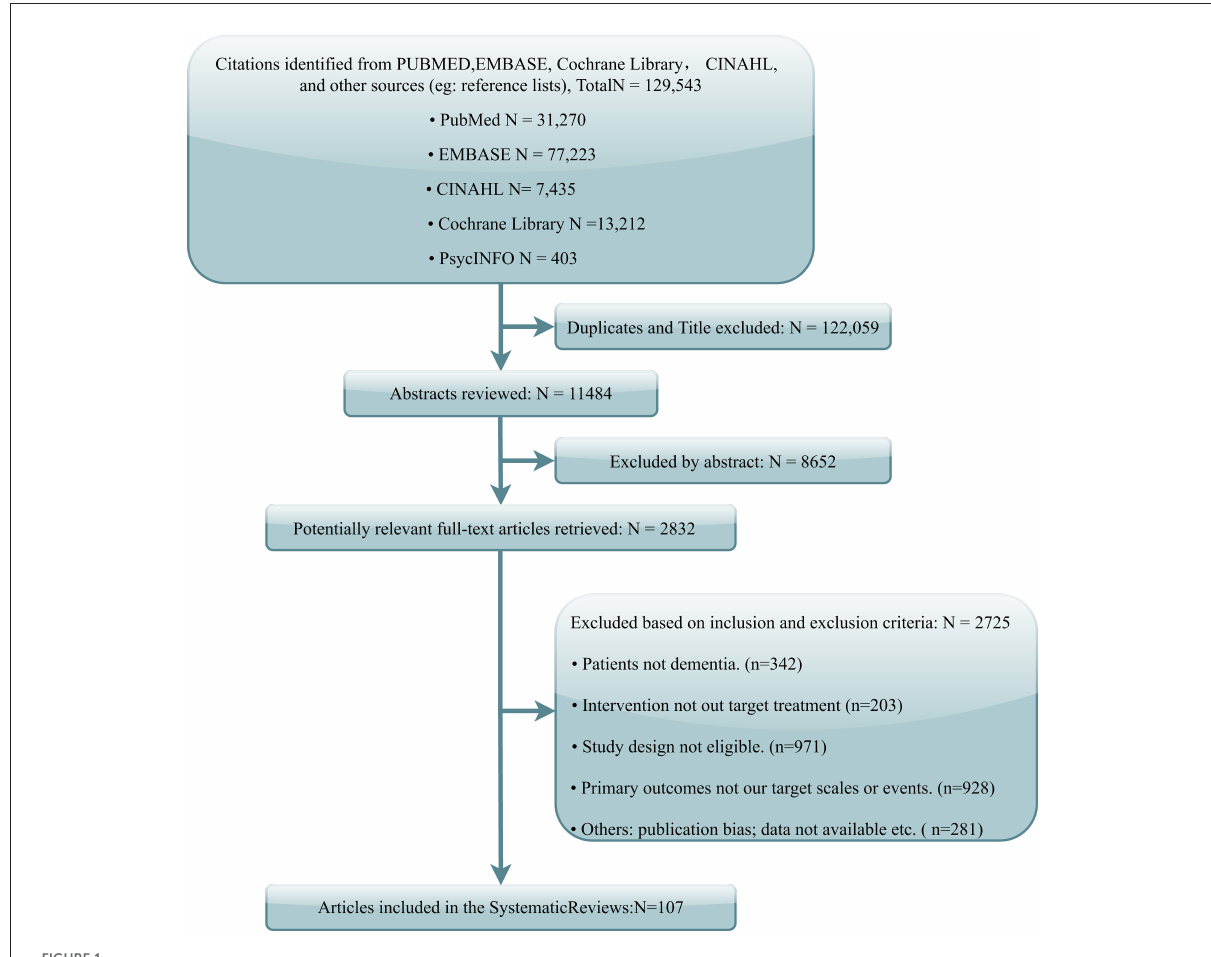
FIGURE1 A flowchart of the screening